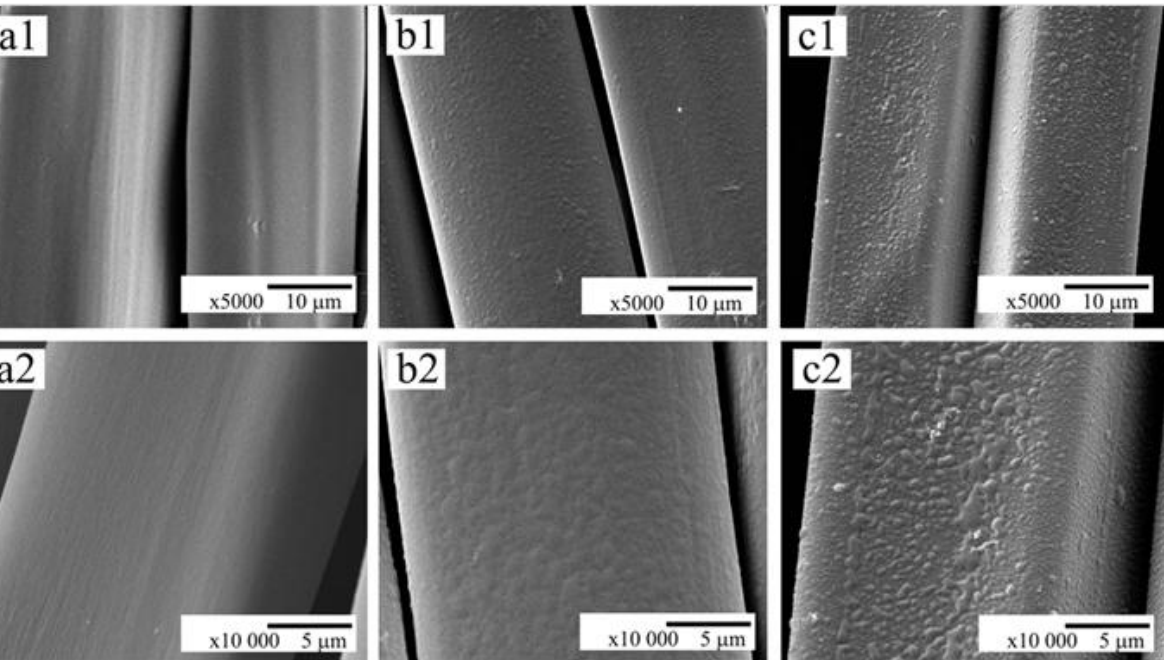
Figure 1. SEM micrographs of untreated and modified fibroin fabrics: ( a1 , a2 ) SFF; ( b1 , b2 ) SFF-1 and ( c1 , c2 ) SFF-2. Magnification: top row 5000×; bottom row